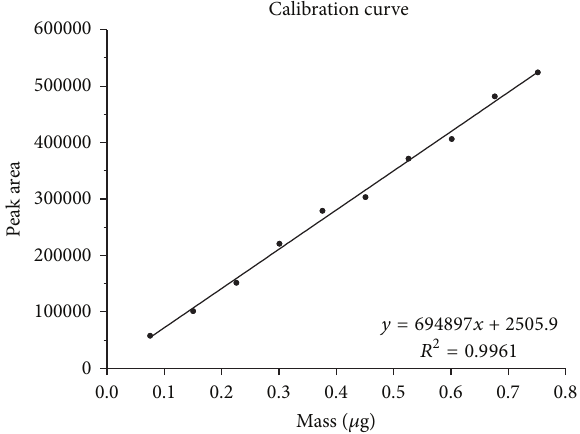
Figure 7: Calibration curve for the determination of tetrachloroe- thene in end-exhaled air; peak area against mass